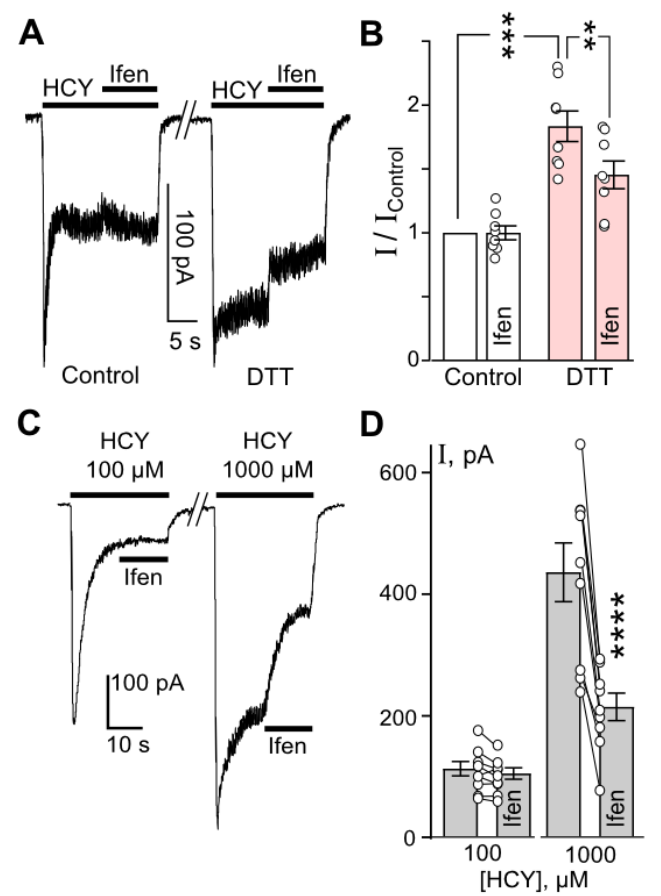
(Figure 5A). Pretreatment of neurons with 1 mM DTT for 90 s caused a significant increase (about 2-fold) of HCY-elicited steady-state currents ( n = 8, p = 0.0002). After DTT treatment, the HCY-activated currents were partially inhibited by ifenprodil ( n = 8, p = 0.0022) (Figure 5B). An appearance of ifenprodil-sensitive component of HCY-induced currents after the treatment with DTT could be explained by the increased contribution of GluN2B-containing NMDARs to HCY-activated currents.